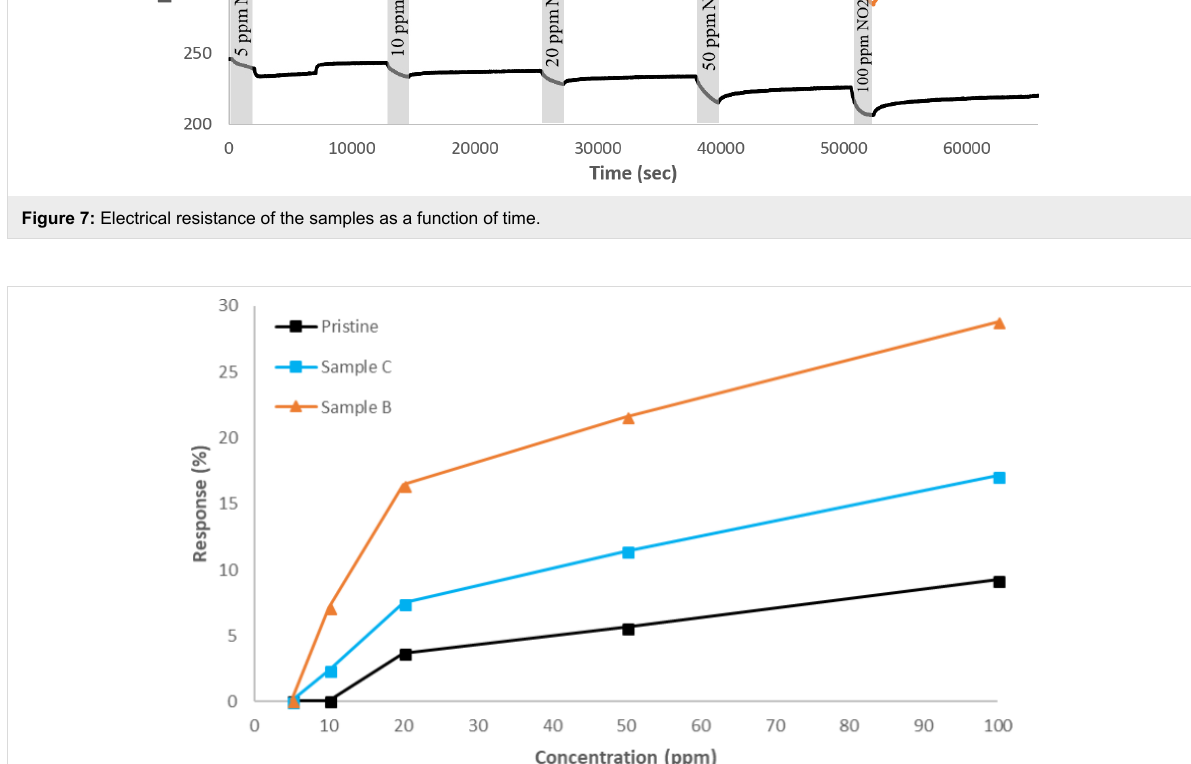
Figure 8: Effect of decoration ratio on the gas sensing